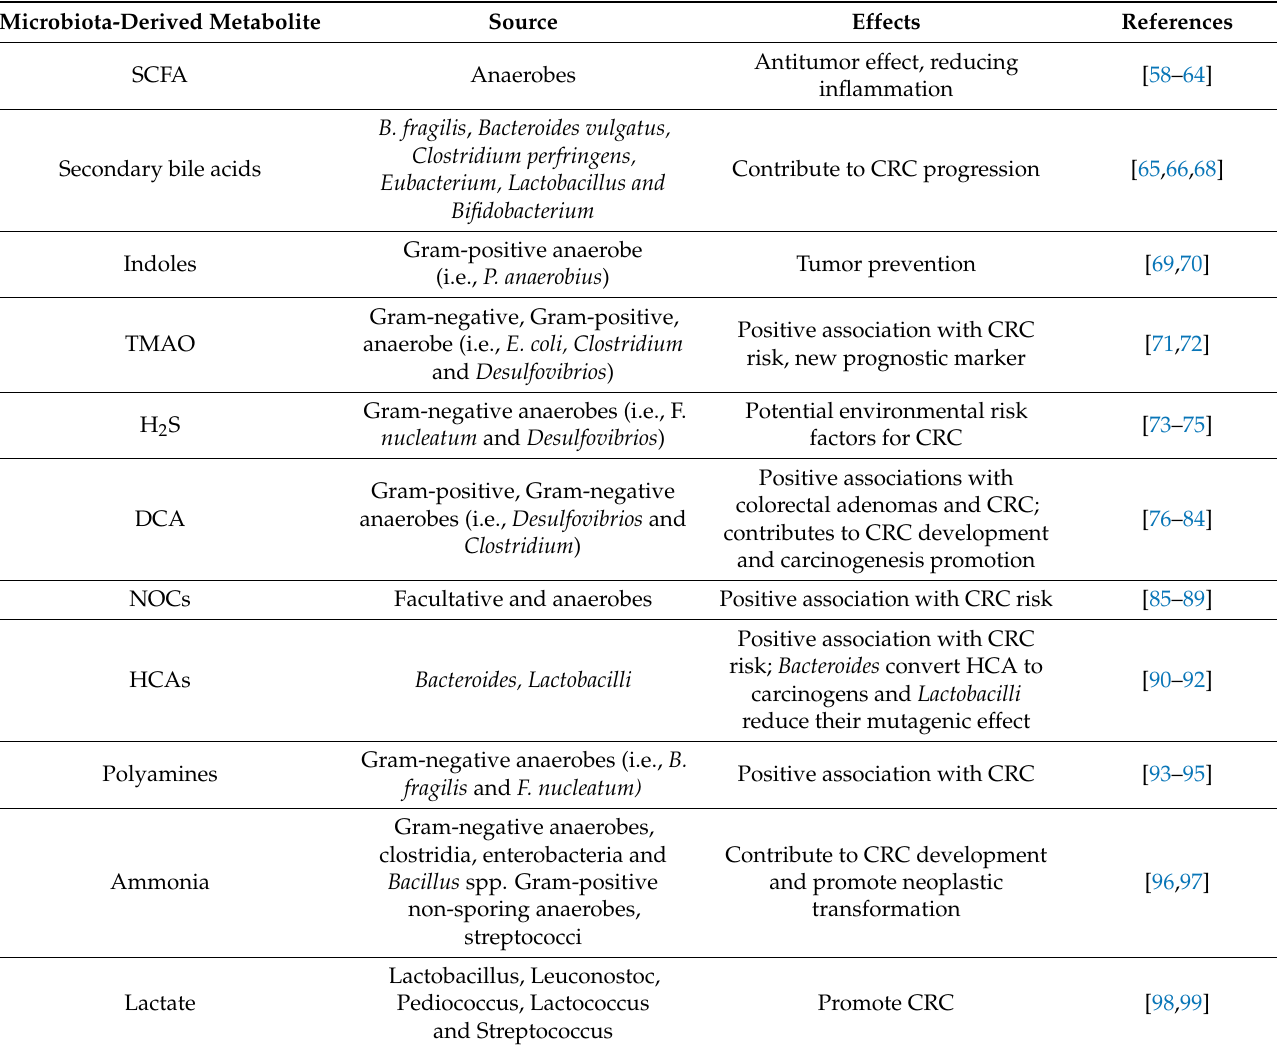
Table 1. Microbiota-derived metabolites, their primary sources and their effects on carcinogenesis. Microbiota-Derived